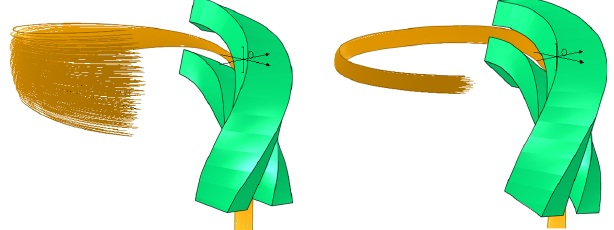
(right).FIG. 1. A traditional spiral inflector (left) showing large vertical divergence, and a field gradient spiral inflector (right) with much improved vertical behavior.